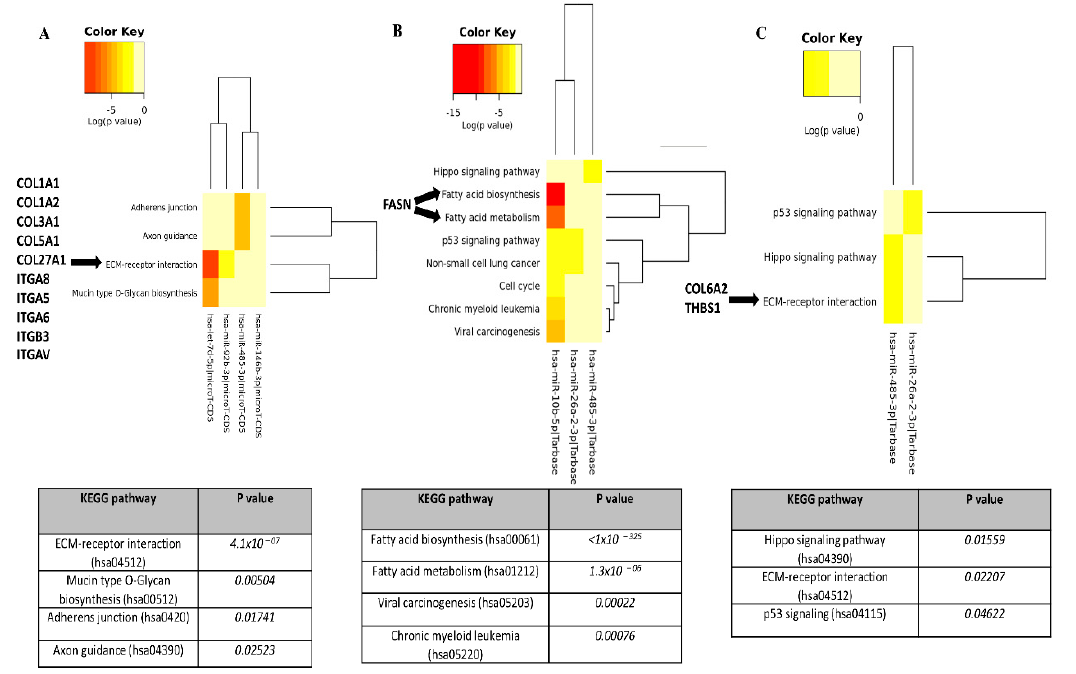
Figure 2. KEGG pathway analysis of significantly changed miRs in RA, PsA, and AS sera. Diana-miPath tool was used to identify specific pathways and their downstream genes, which were negatively regulated by significantly changed miRs in RA ( A ), PsA ( B ), and AS ( C ).